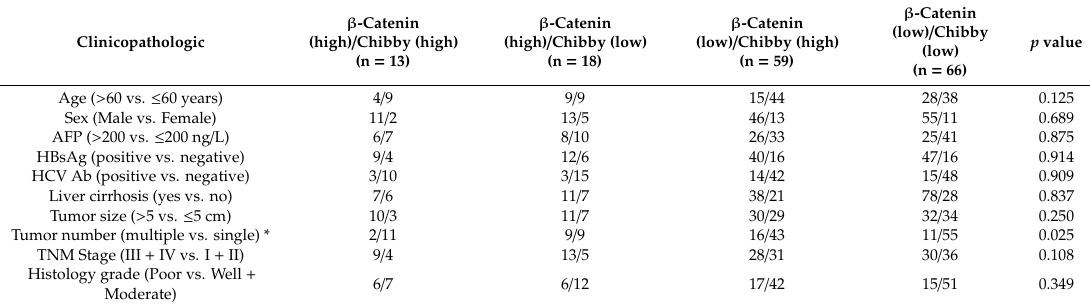
Table 1. Correlation of nuclear expression of β -catenin / Chibby with clinicopathological characteristics in 156 patients with hepatocellular carcinoma (HCC).